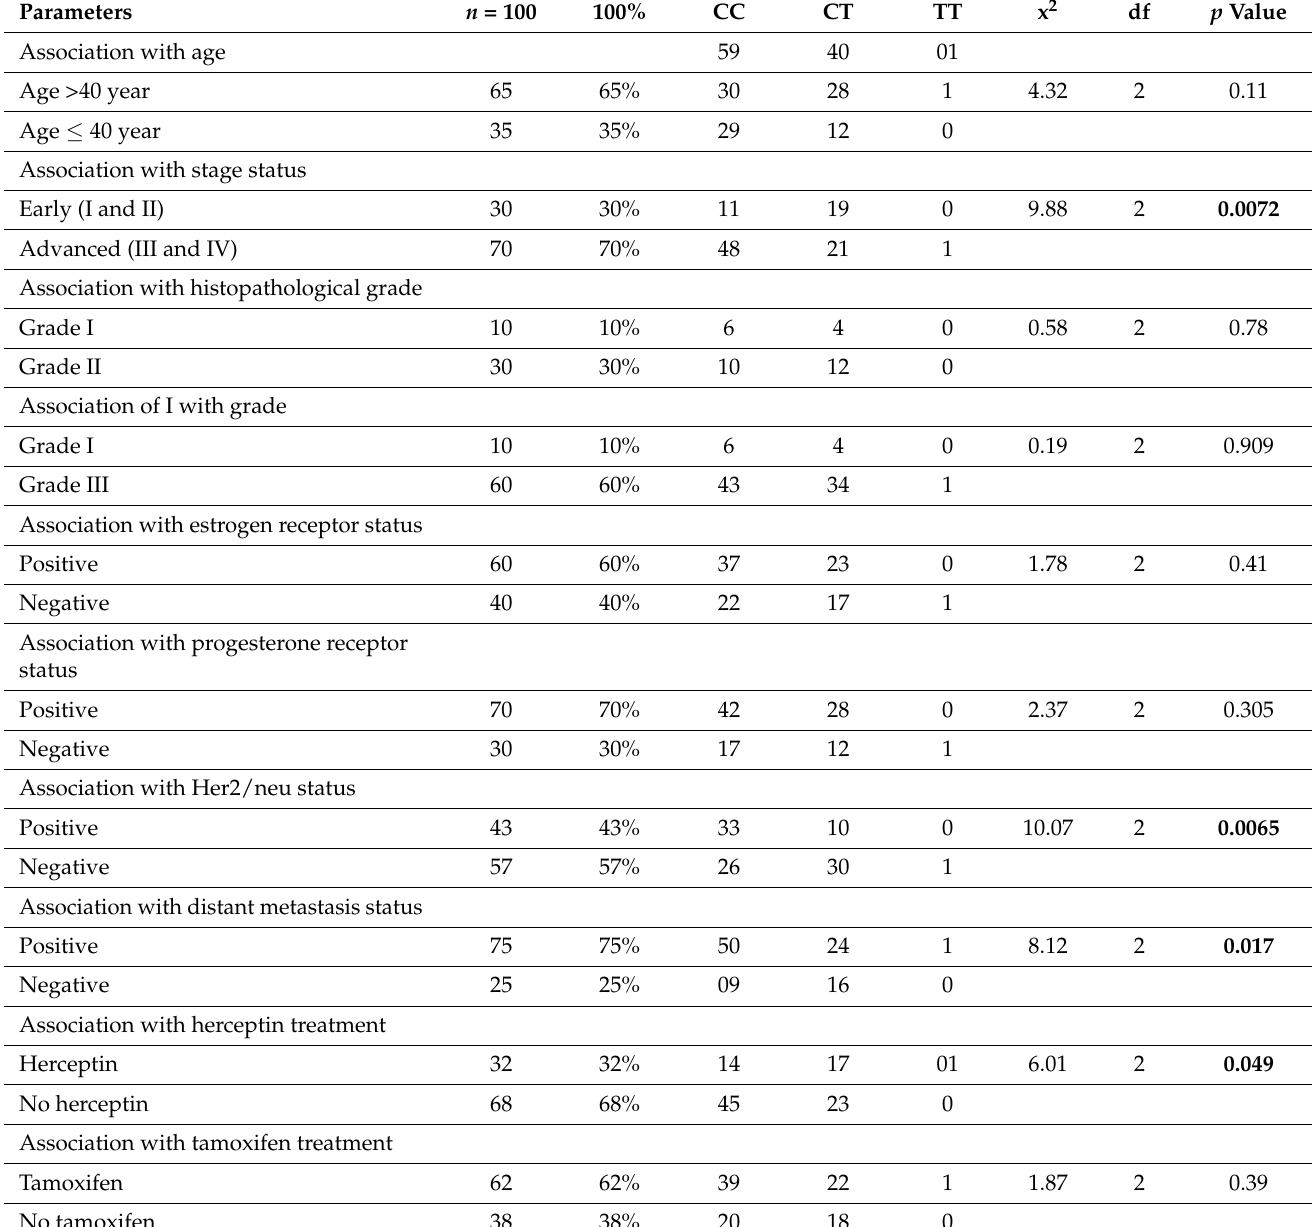
Table 13. Association of miR-196a C > T genotypes with clinicopathological features of the breast cancer patients. p values in bold are